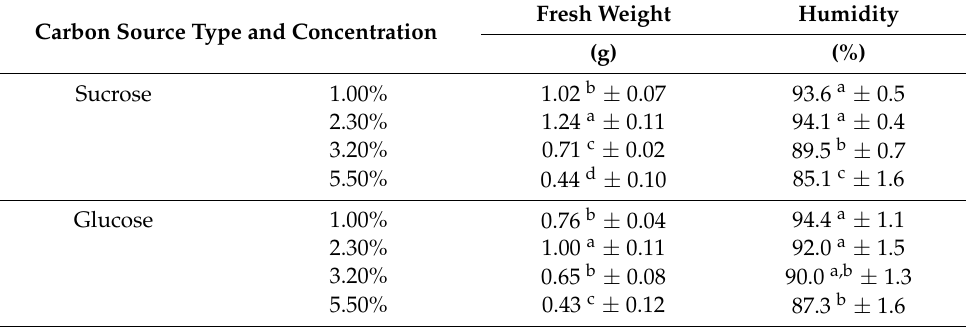
Table 4. Fresh weight and humidity content of T. officinale callus derived from hypocotyls two weeks after induction under different carbon source types (sucrose and glucose) and concentrations (1.0%, 2.3%, 3.2%, and 5.5%) (medium MS supplemented with 0.1 mg/L of NAA and 2.0 mg/L of BAP, at 18 ± 2 ◦ C and 0/24 h light/dark). Fresh Weight Humidity Carbon Source Type and Concentration